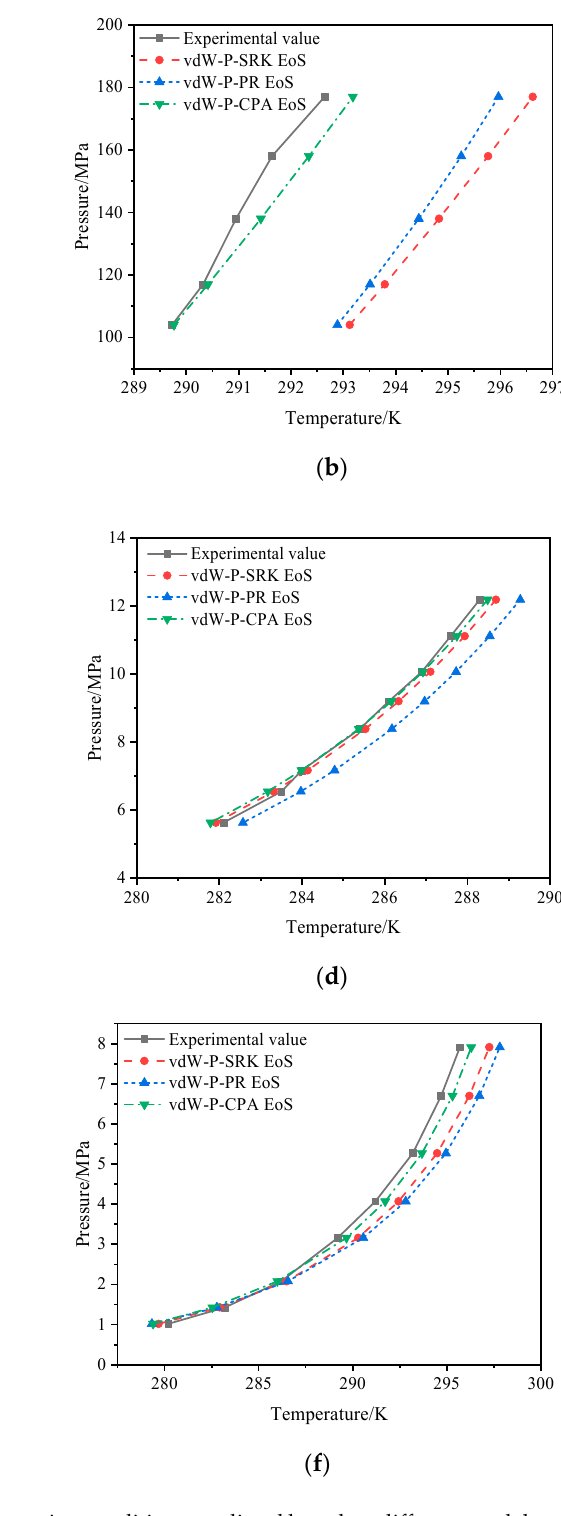
As depicted in Figure 1, the hydrate formation temperatures predicted by the vdW-